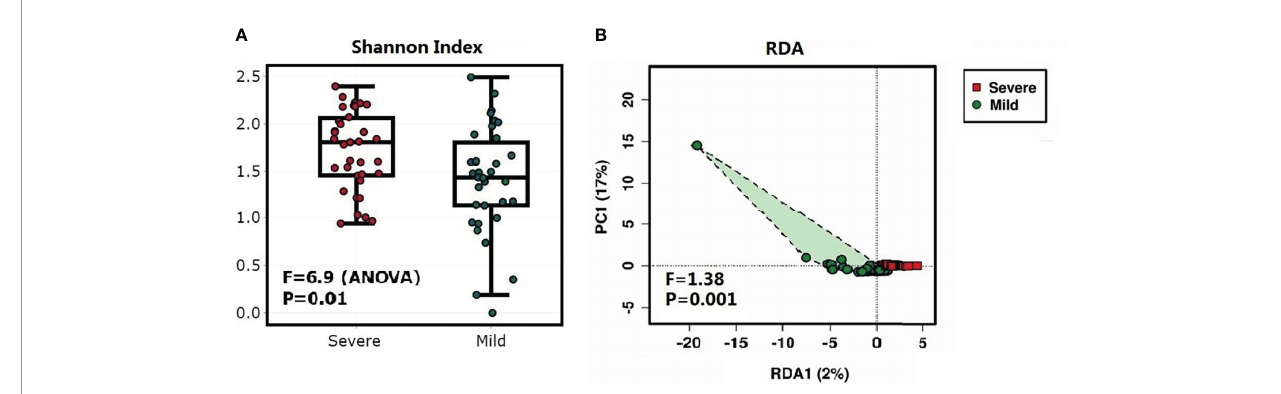
FIGURE 2 | Diversity analysis of the dermic microbiome of patients with paronychia. ( A ) Comparison of alpha diversity of dermic microbiome using the Shannon ’ s a -index between patients with mild paronychia (green) and those with severe paronychia (red). (B) Redundancy analysis of dermic microbiome between the mild (green) and severe (red) paronychia groups.